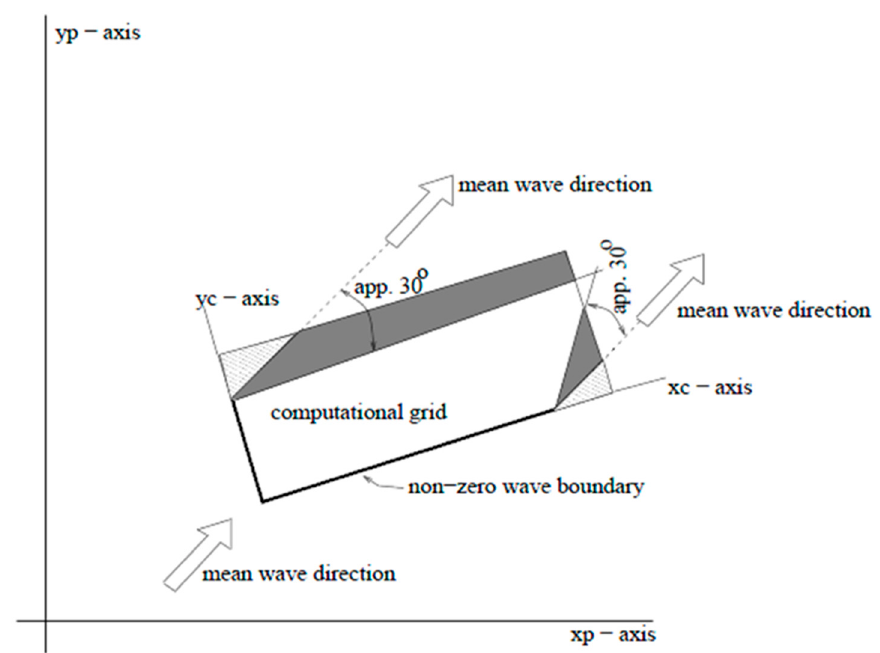
Figure 5. Schematic diagram of calculation distortion area caused by unknown boundary.